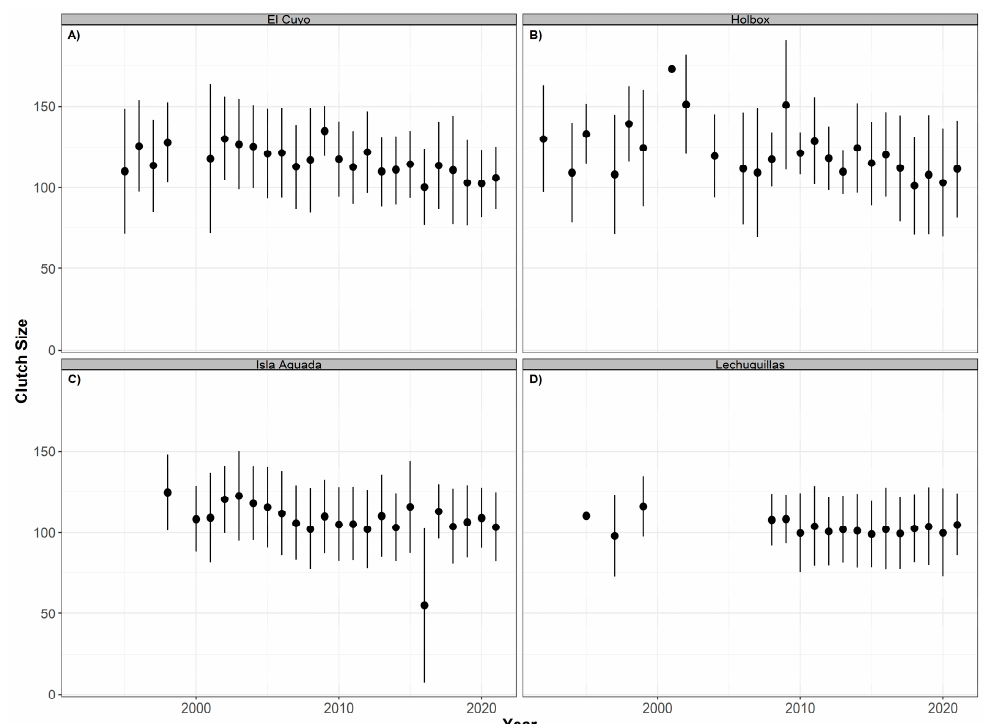
Figure 7. Time series of clutch size (annual mean ± SD) for green turtles ( Chelonia mydas ) nesting at El Cuyo ( A ), Holbox ( B ), Isla Aguada ( C ), and Lechuguillas ( D ) from 1990 to 2021. As for the hatching (HS) and emergence (ES) success, we did not detect a significant temporal trend for hawksbill (HS: p > 0.05, R 2 = 0.306 and ES: p > 0.05, R 2 = 0.311) or green (HS: p > 0.05, R 2 = 0.195 and ES: p > 0.05, R 2 = 0.298) turtles in any of the nesting sites. The overall mean hatching success for hawksbill turtles was higher in Holbox (91.72% ± 22.75),